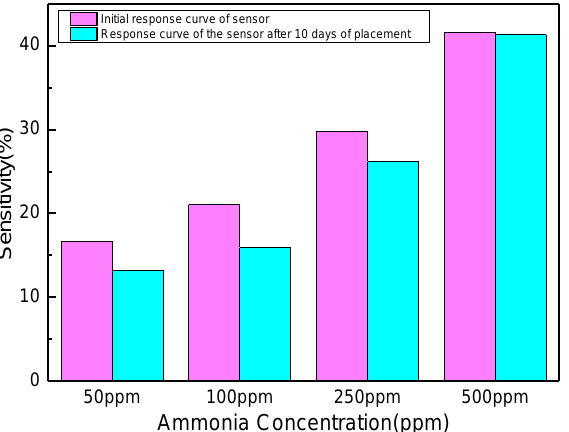
Figure 11. Retention characteristics of UVO 1-min sample sensor under different ammonia concentrations. Table 1. Retention and stability of ion sensitive GO-Si based metal-semiconductor junction resistor gas sensor.